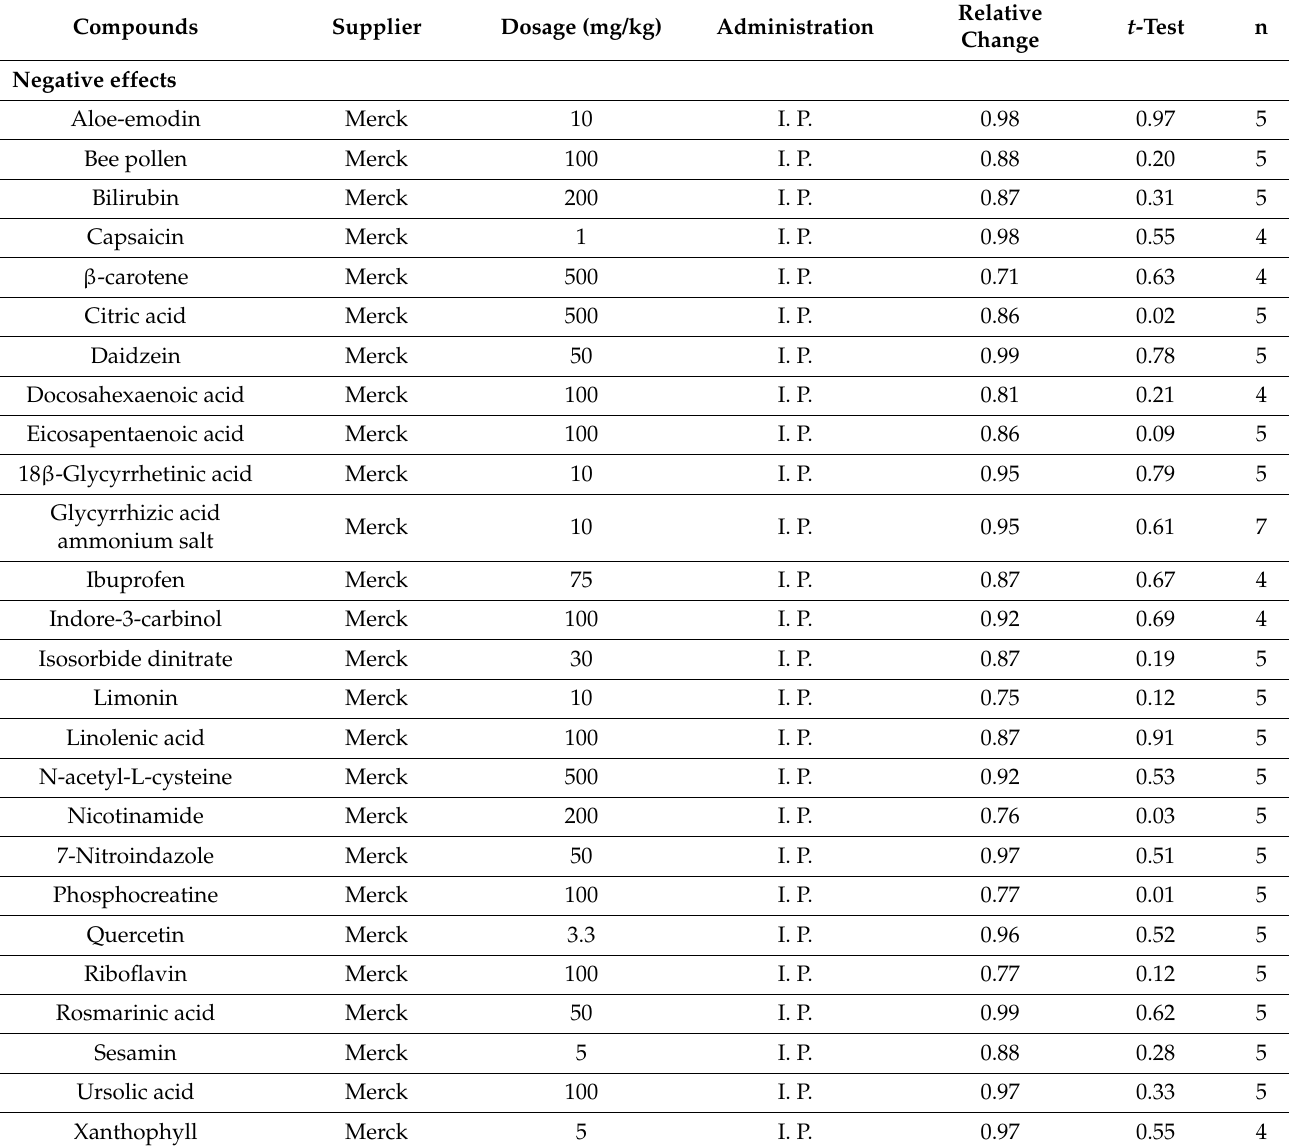
Table 2. Negative effects of compounds on the running activity of muscle- Sod2 -/-